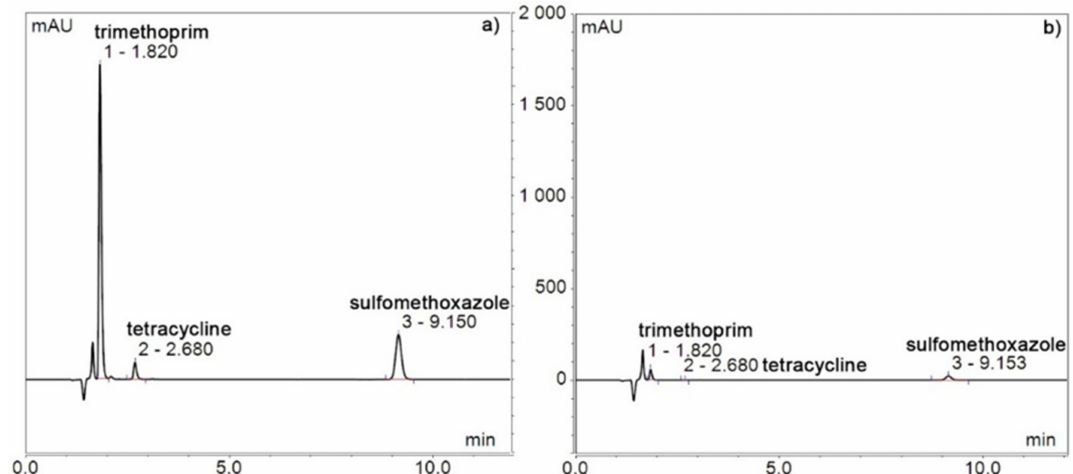
Figure 8. HPLC spectra of a mixture of ATB at time zero ( a ), a mixture of ATB after 1 day ( b ), and the SWCNT-MO-200